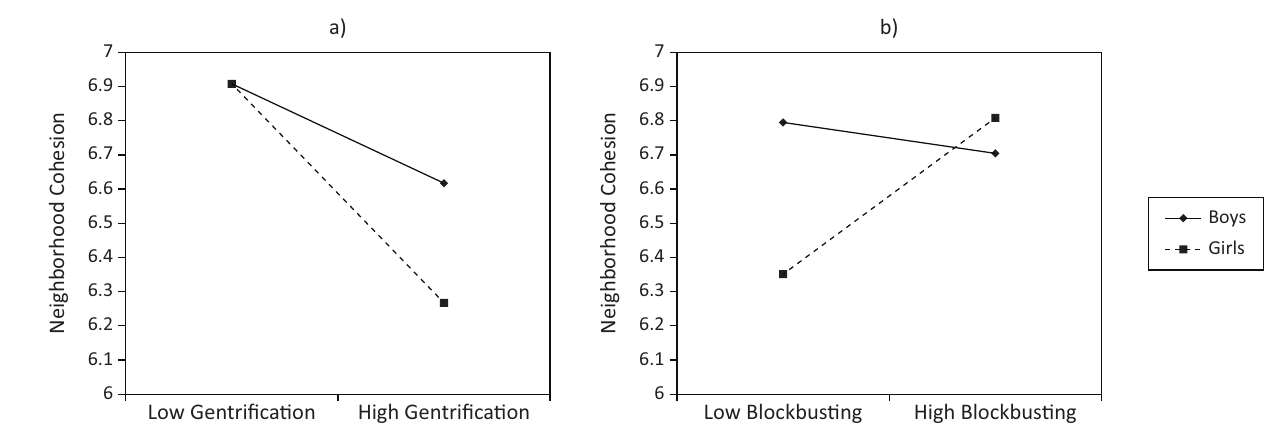
Figure 3. Plots of two‐way interactions between sex and (a) gentrification and (b) blockbusting.